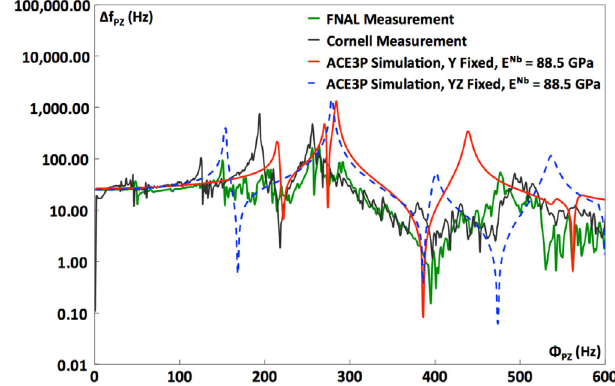
FIG. 13. Measurements and simulations of cavity detuning as a function of the piezoactuator frequency — the curves are described in the